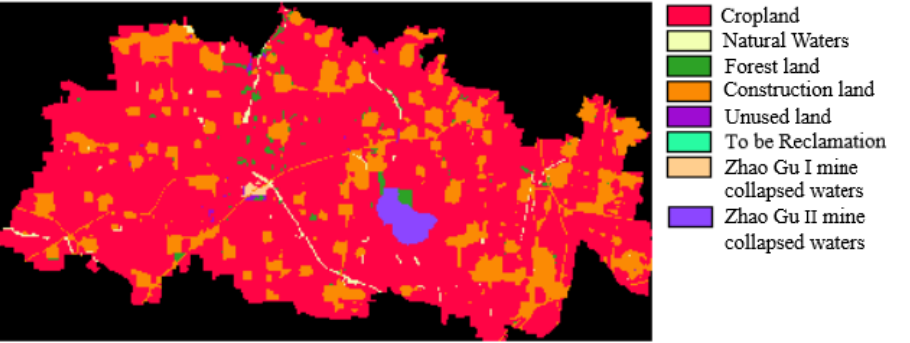
Figure 6. Prediction map of the spatial distribution pattern of landscape types in 2029. Table 5. Trend of landscape level index change during 2019–2029.